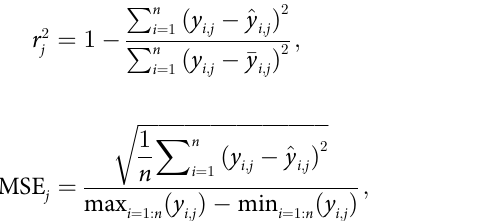
Table 1. Aggregate out-of-sample r 2 and NRMSE for sequential nowcasting, indexed by methodology and prevalence. Child Stunting Child Wasting Healthy Weight Asset Poverty Underwt Women